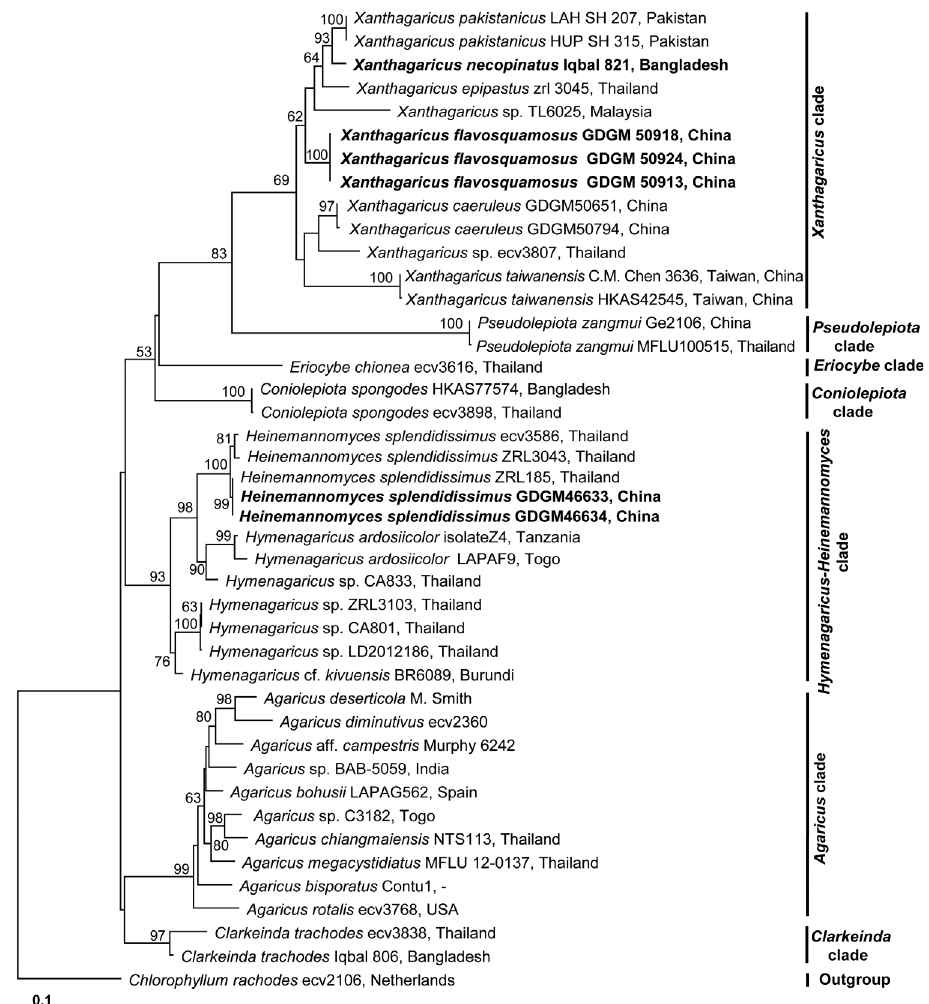
Figure 1. Phylogenetic relationships of Xanthagaricus species and its allied genera inferred from ITS-28S data using ML method. RAxML bootstrap support values (ML BS, ≥50%) are indicated on the branches at nodes. The two new species of Xanthagaricus from Bangladesh and China, and Heinemannomyces splen- didissimus from China, are highlighted in bold on the tree. Herbarium or voucher specimen numbers and country names are provided after the species name. Chlorophyllum rachodes is rooted as the outgroup. Bar: indicates 0.1 expected change per site per